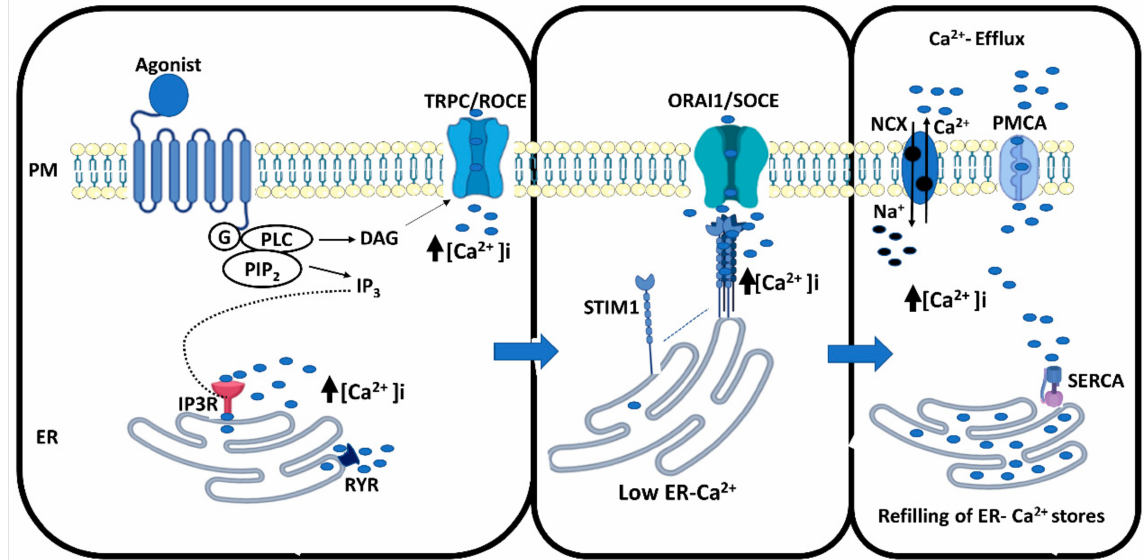
Figure 1. Mechanisms of cellular calcium signaling. A hormone or ligand binds to the G protein-coupled receptor and activates G-protein subunits Gi, Gq (G) or both, which activates phospholipase C (PLC), stimulating production of two secondary messengers; diacylglycerol (DAG) and inositol 1,4,5-trisphosphate (IP3). DAG potentially stimulates TRPC calcium channels in the plasma membrane and triggers calcium influx into the cells, referred to as receptor-operated calcium entry. IP3 binds to the IP 3 receptors present on the endoplasmic reticulum (ER) membranes. This leads to the release of calcium from ER stores. These mechanisms rapidly increase cytosolic free calcium concentrations ([Ca 2+ ] i ). The depletion of the ER is sensed by STIM1 molecules on the ER membrane, which rapidly tetramerize and bind to ORAI1 calcium channels on the plasma membrane, resulting in the opening of these channels and a huge influx of calcium into the cells, referred to as store-operated calcium entry. To avoid an overload of ([Ca 2+ ] i ) in the cytoplasm, the pumps SERCA, NCX and PMCA, are activated and calcium is shuttled back into the ER to refill the stores, or exported out from the cells, respectively. The events described are shown in three different panels for